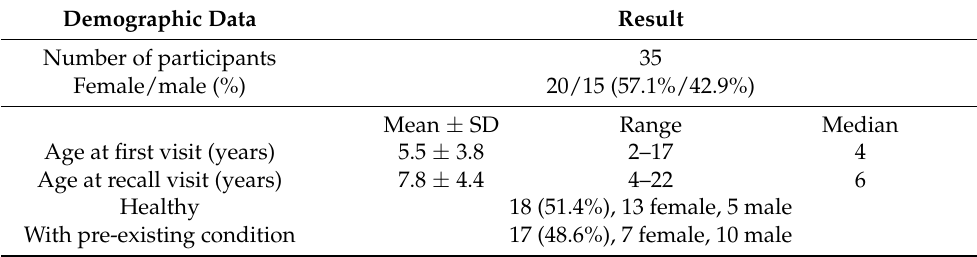
Table 1. Demographic data for the